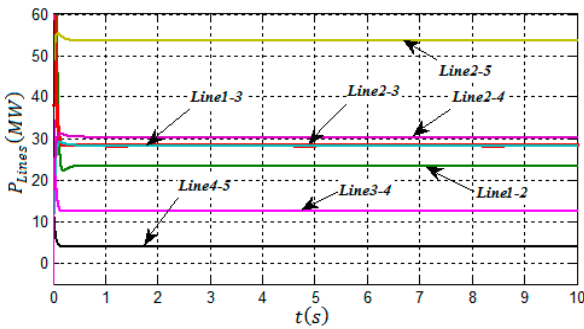
Figure 10. Active power flow on the lines before the integration of the wind farm.